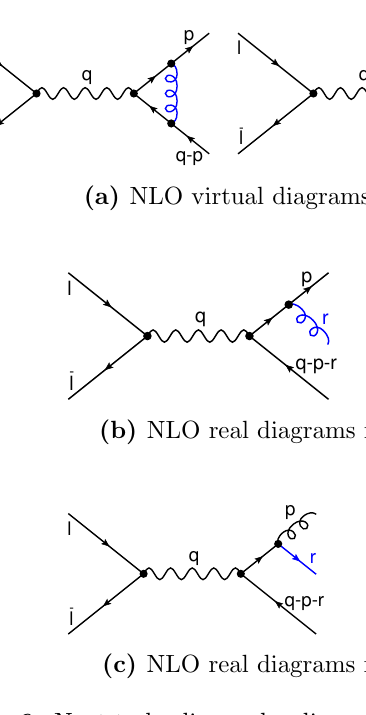
Figure 6. Next-to-leading order diagrams relevant for 2-parton